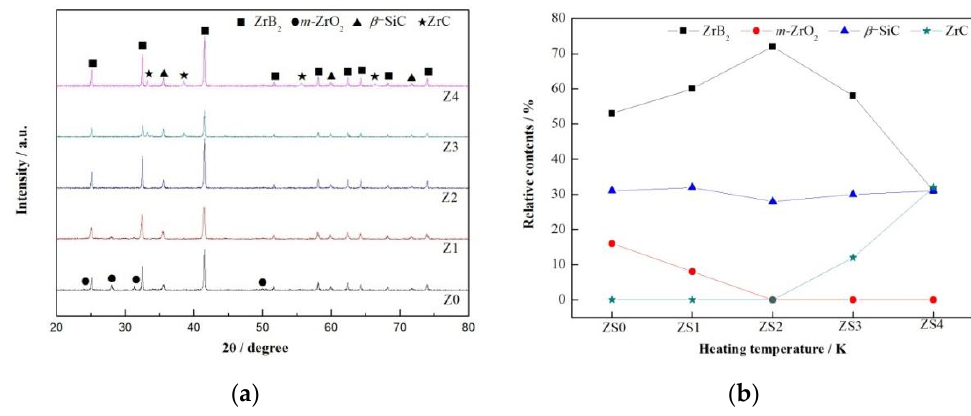
Figure 3. Phase composition of samples ZS0–ZS4 heated at 1723 K for 3 h, n (Fe): n (ZrSiO 4 ) = 0:1, 0.1:1, 0.2:1, 0.3:1, and 0.4:1, respectively: ( a ) XRD patterns; ( b ) relative contents of the crystalline phase.